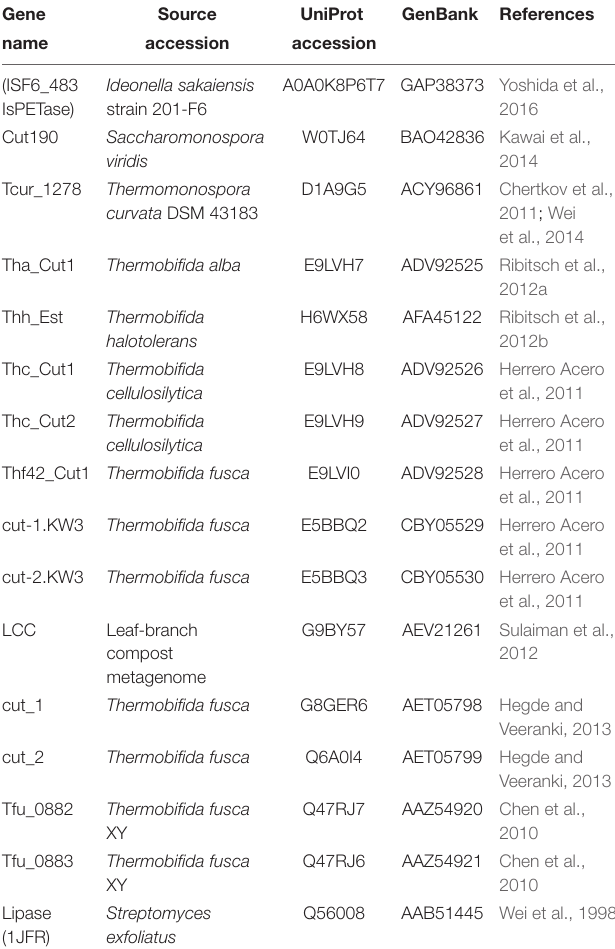
TABLE 1 | Reference data set comprising of 15 PETase-like enzymes with demonstrated PET-degrading activity, including the ISF6_483 protein from Ideonella sakaiensis strain 201-F6 (IsPETase), and additionally the cutinase-like lipase from Streptomyces exfoliatus (PDB ID: 1JFR). Gene